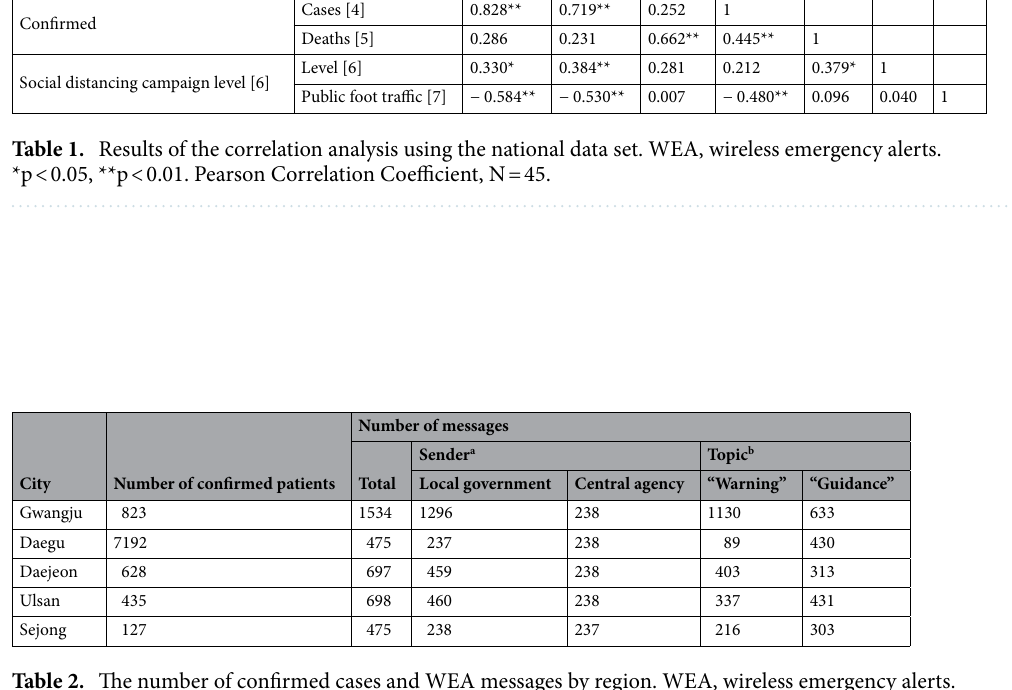
Table 2. The number of confirmed cases and WEA messages by region. WEA, wireless emergency alerts. a Local governments send messages to residents of their administrative districts. However, central agencies, such as the Korea Disease Control and Prevention Agency, generally send messages to the entire Korean population. b Some messages contained both “warning” and “guidance” topics. Therefore, the sum of the “warning” and “guidance” topics is larger than the total number of